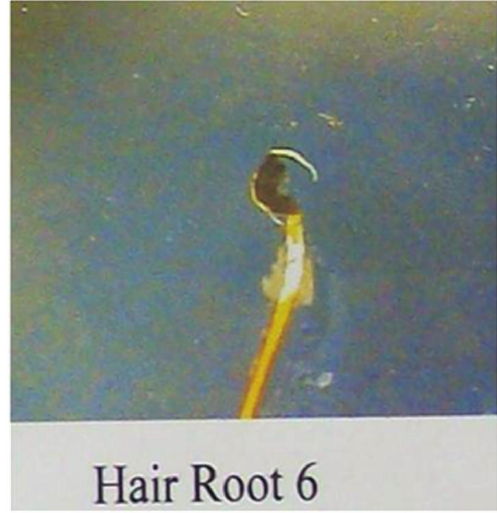
Figure 6: Trichoanalysis showing pili